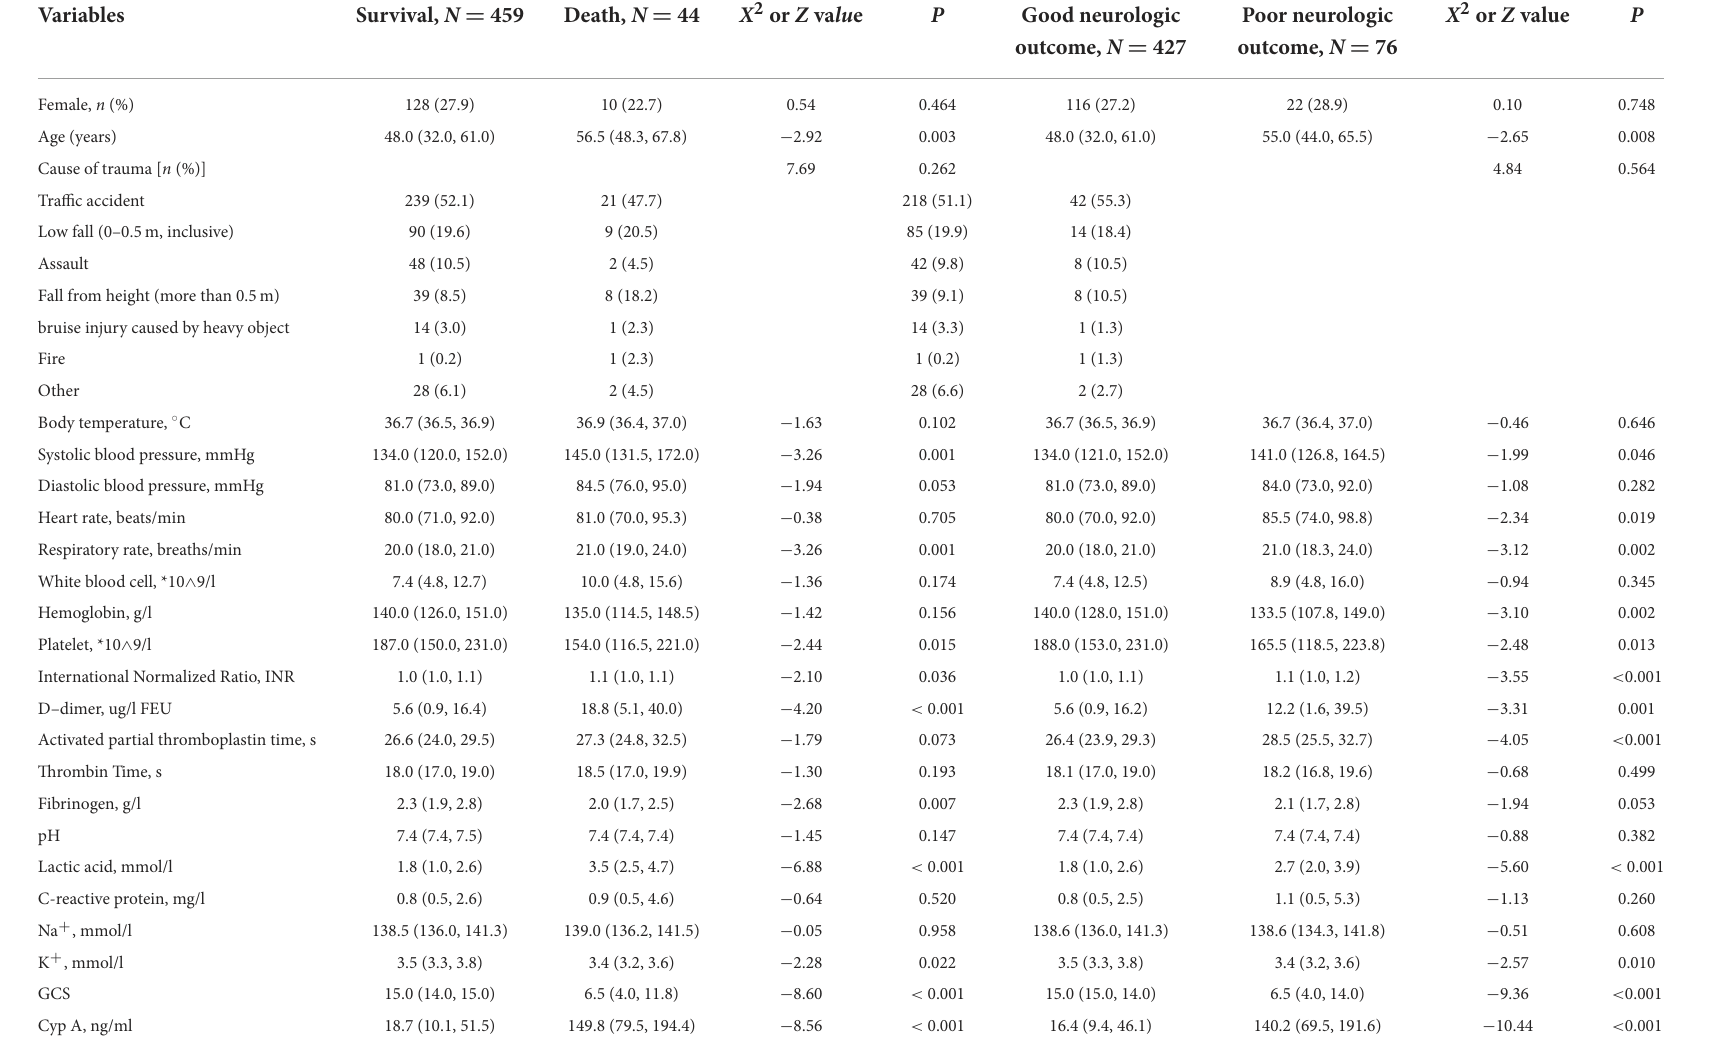
TABLE 1 Clinic information of the study population stratified by survival status and neurologic outcome. Variables Survival, N = 459 Death, N = 44 X 2 or Z va lu e Good